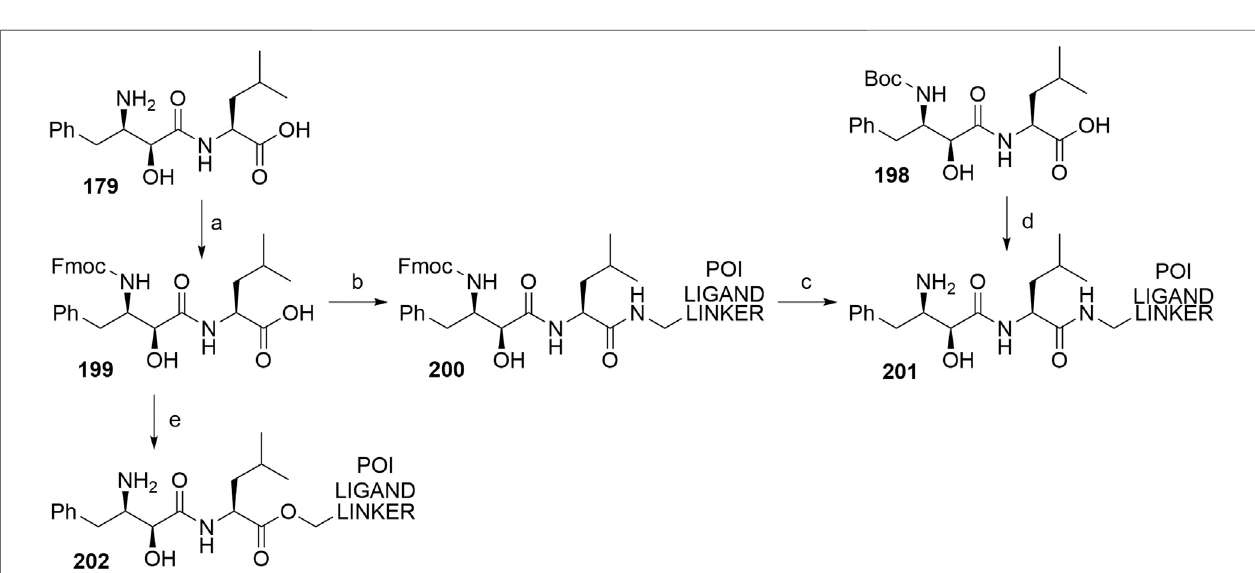
SCHEME 34 | Linker attachment via an amide or an ester bond. Reagents and conditions: a) Fmoc-Cl, K 2 CO 3 , THF, H 2 O, 0 ° C to rt, 24 h, 97% yield (Itoh et al., 2010);a)Fmoc-Cl,K 2 CO 3 ,THF,H 2 O,rt,81%yield(Ohokaetal.,2014);b)reagents,conditions,andyieldsarecollectedin Table6 ;c)2 MMe 2 NHinMeOH,rt,84 – 89% yield for conjugates used (Ohoka et al., 2014); 2 M Me 2 NH in MeOH, rt, 6 h, 37% yield for conjugate used (Ohoka et al., 2017a); d) i. POI ligand-linker-NH 2 , EDC, HOBt, DIPEA,CH 2 Cl 2 ,rt,12 h,77 – 86%yieldforconjugatesused;ii.6MHCl(aq),THF,rt,6 h,quant.(Okuhiraetal.,2016);e)i.POIligand-linker-OH, EDC,HOBt,DIPEA, CH 2 Cl 2 , 0 ° C to rt, 17 h, 36% yield for conjugate used; ii. DBU, dodecyl mercaptan, CH 2 Cl 2 , rt, 1 h (Itoh et al., 2010).